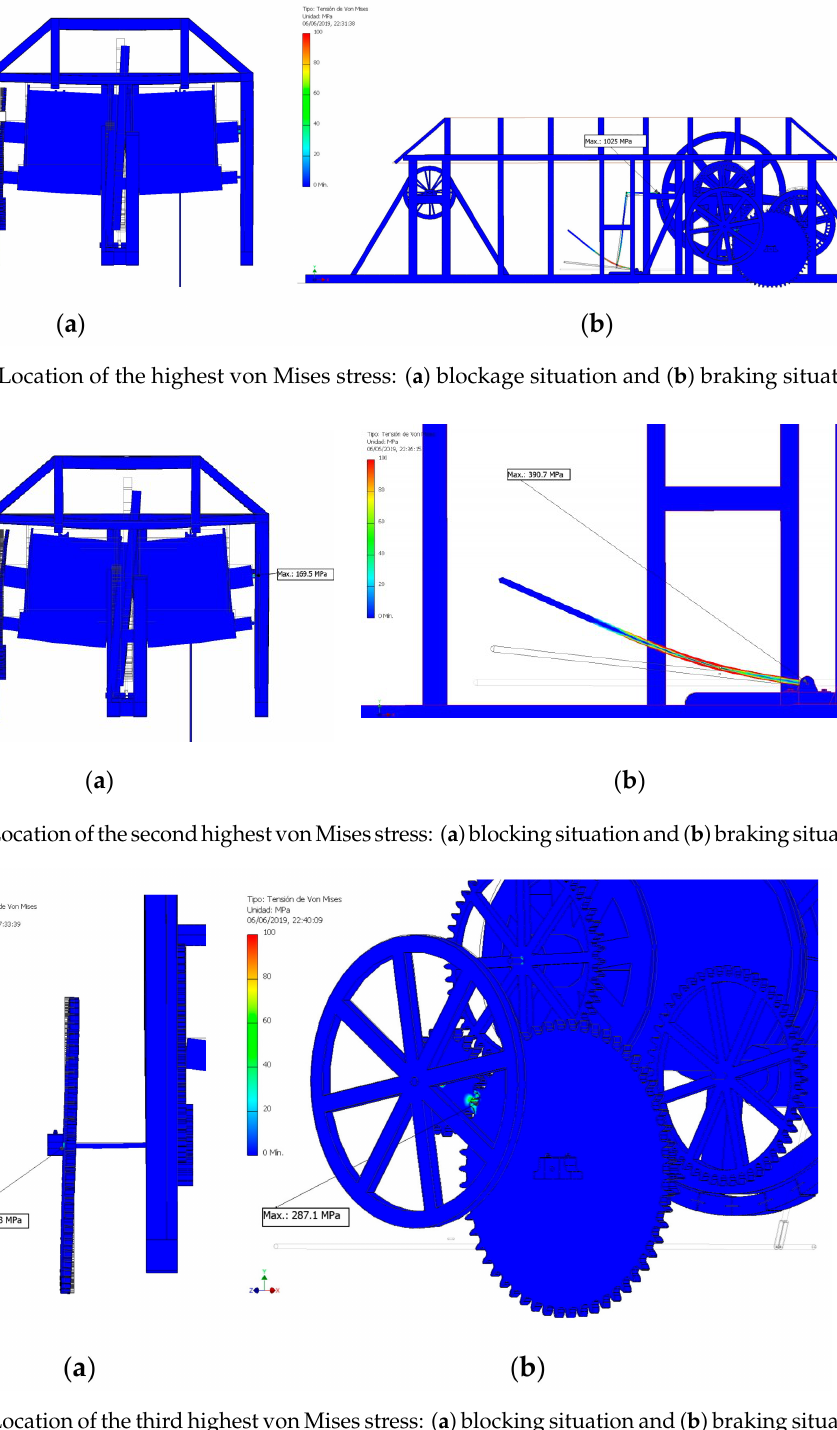
Figure 20. Location of the third highest von Mises stress: ( a ) blocking situation and ( b ) braking situation.